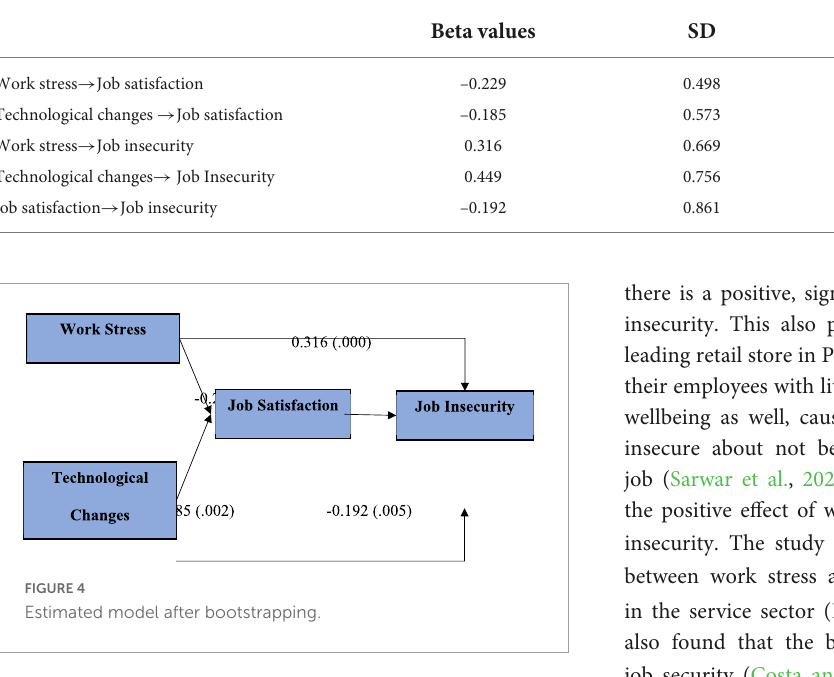
TABLE 6 Path coefficient (direct effects).